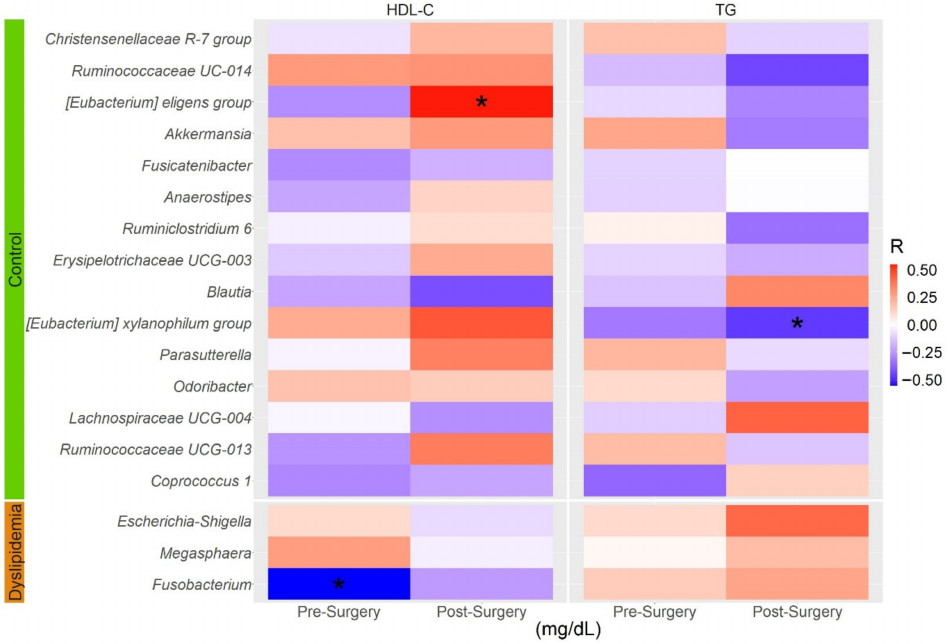
Figure 7. Heatmap of Spearman’s pairwise correlation coefficients between bacterial genera identified by LEfSe and lipid levels. Blue squares indicate negative correlations, and red squares indicate positive correlations. BMI, body mass index; HDL-C, high density lipoprotein-cholesterol; TG, triglycerides * p <